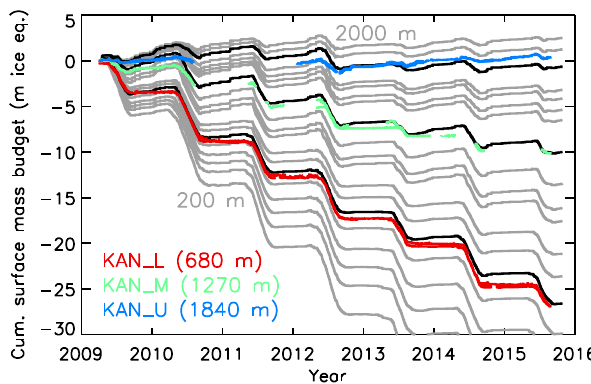
Figure 5. Modeled (grey) and measured (colors) cumulative sur- face mass balance in the Kangerlussuaq catchment of the Green- land ice sheet. Model values are given for every 100m elevation bin (200–2000ma.s.l.). Black lines denote the bins closest to the “KAN” weather station elevations, at 700, 1300 and 1800m eleva- tion. Observation time series are composites of two sensors; note that winter accumulation at KAN_M is not captured by one of the